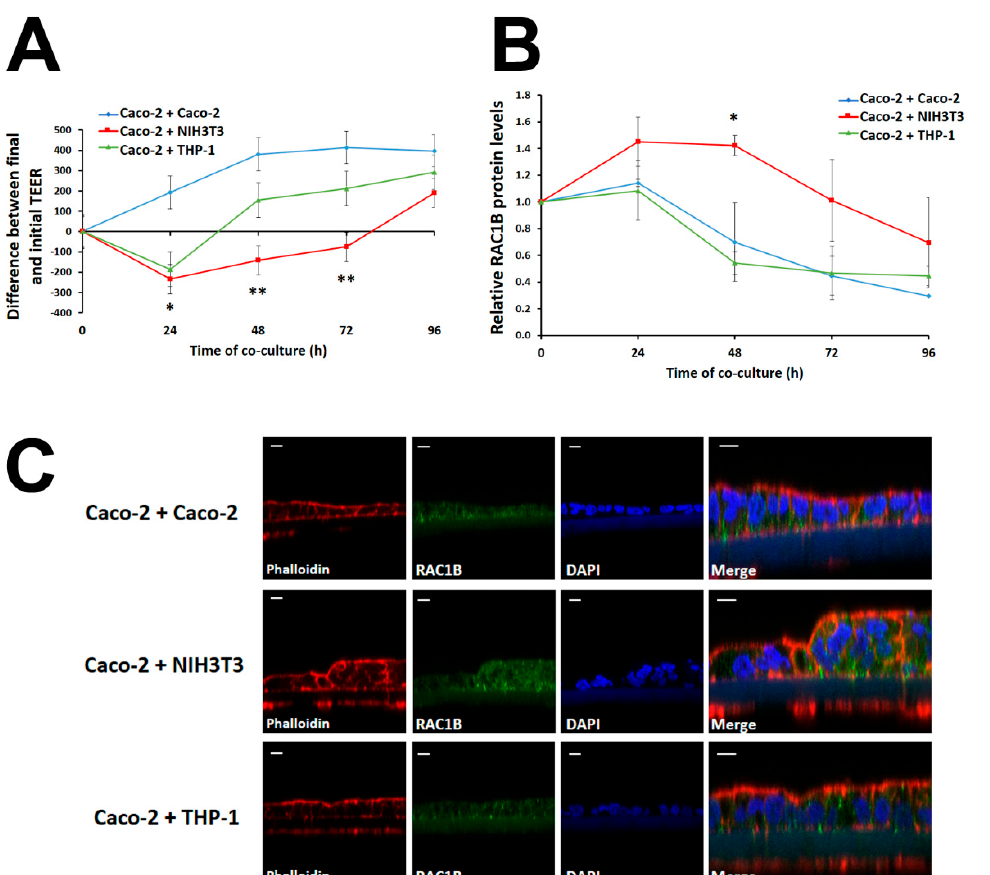
Figure 2. RAC1B levels and changes in polarization of Caco-2 cells under co-culture with stromal cells. Filter inserts with fully polarized Caco-2 monolayers were placed into pre-seeded 24-well plates with Caco-2 (control), NIH3T3 fibroblasts, or THP-1 monocytes. The Caco-2 cells were exposed to different co-culture lengths: 0 h, 24 h, 48 h, 72 h, and 96 h. ( A ) Changes in the polarization state were assessed by the differences between final and initial TEER measurement ( Δ TEER) of Caco-2 after different co-culture times. ( B ) RAC1B protein levels in lysates from polarized Caco-2 cells were analysed by SDS-PAGE and WB techniques after different co-cultures times. Data are shown as fold-change relative to the 0 h control and represent means ± SEM, of at least 8 independent experiments. Statistical analysis was carried out with two-way ANOVA tests (( A ) F = 5.39, p = 0.0458; ( B ) F = 4.77, p = 0.0576), followed by Bonferroni post hoc tests to assess significant differences from control conditions (Caco-2 + Caco-2) at each timepoint (* p < 0.05; ** p < 0.01). ( C ) Morphology of polarized Caco-2 cell layers after 48 h of co-culture with stromal cells. Cell polarization and RAC1B expression and localization were analysed by confocal immunofluorescence microscopy. Merge is the overlay of three confocal immunofluorescence images, which detected cell nuclei in blue (DAPI), the localization of endogenous RAC1B protein in green, and actin (phalloidin) in red; scale bars = 10 μ m.